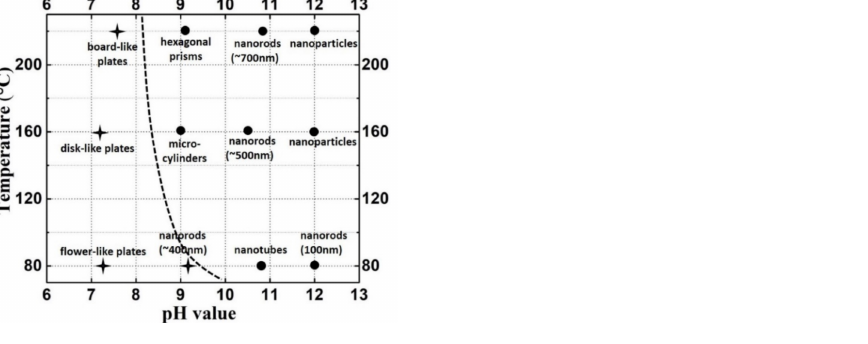
Figure 8. Morphology distribution in a temperature–pH diagram. (Closed circle: Eu(OH) 3 ; star: Eu 2 (OH) 5 NO 3 · 2H 2